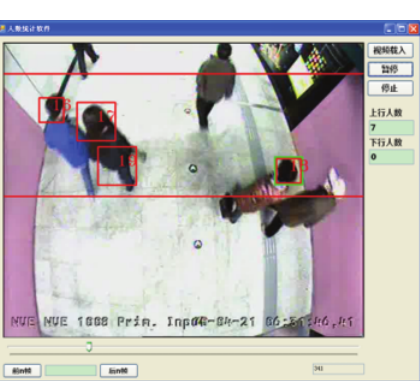
Figure 22: Pedestrian counting